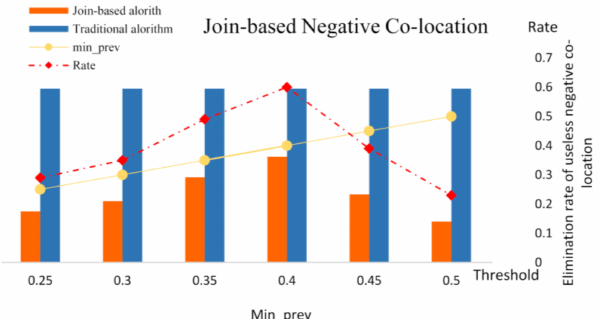
Figure 6. A comparison between the negative C-LP algorithm based on the J-B and traditional algorithms with the change in threshold value.